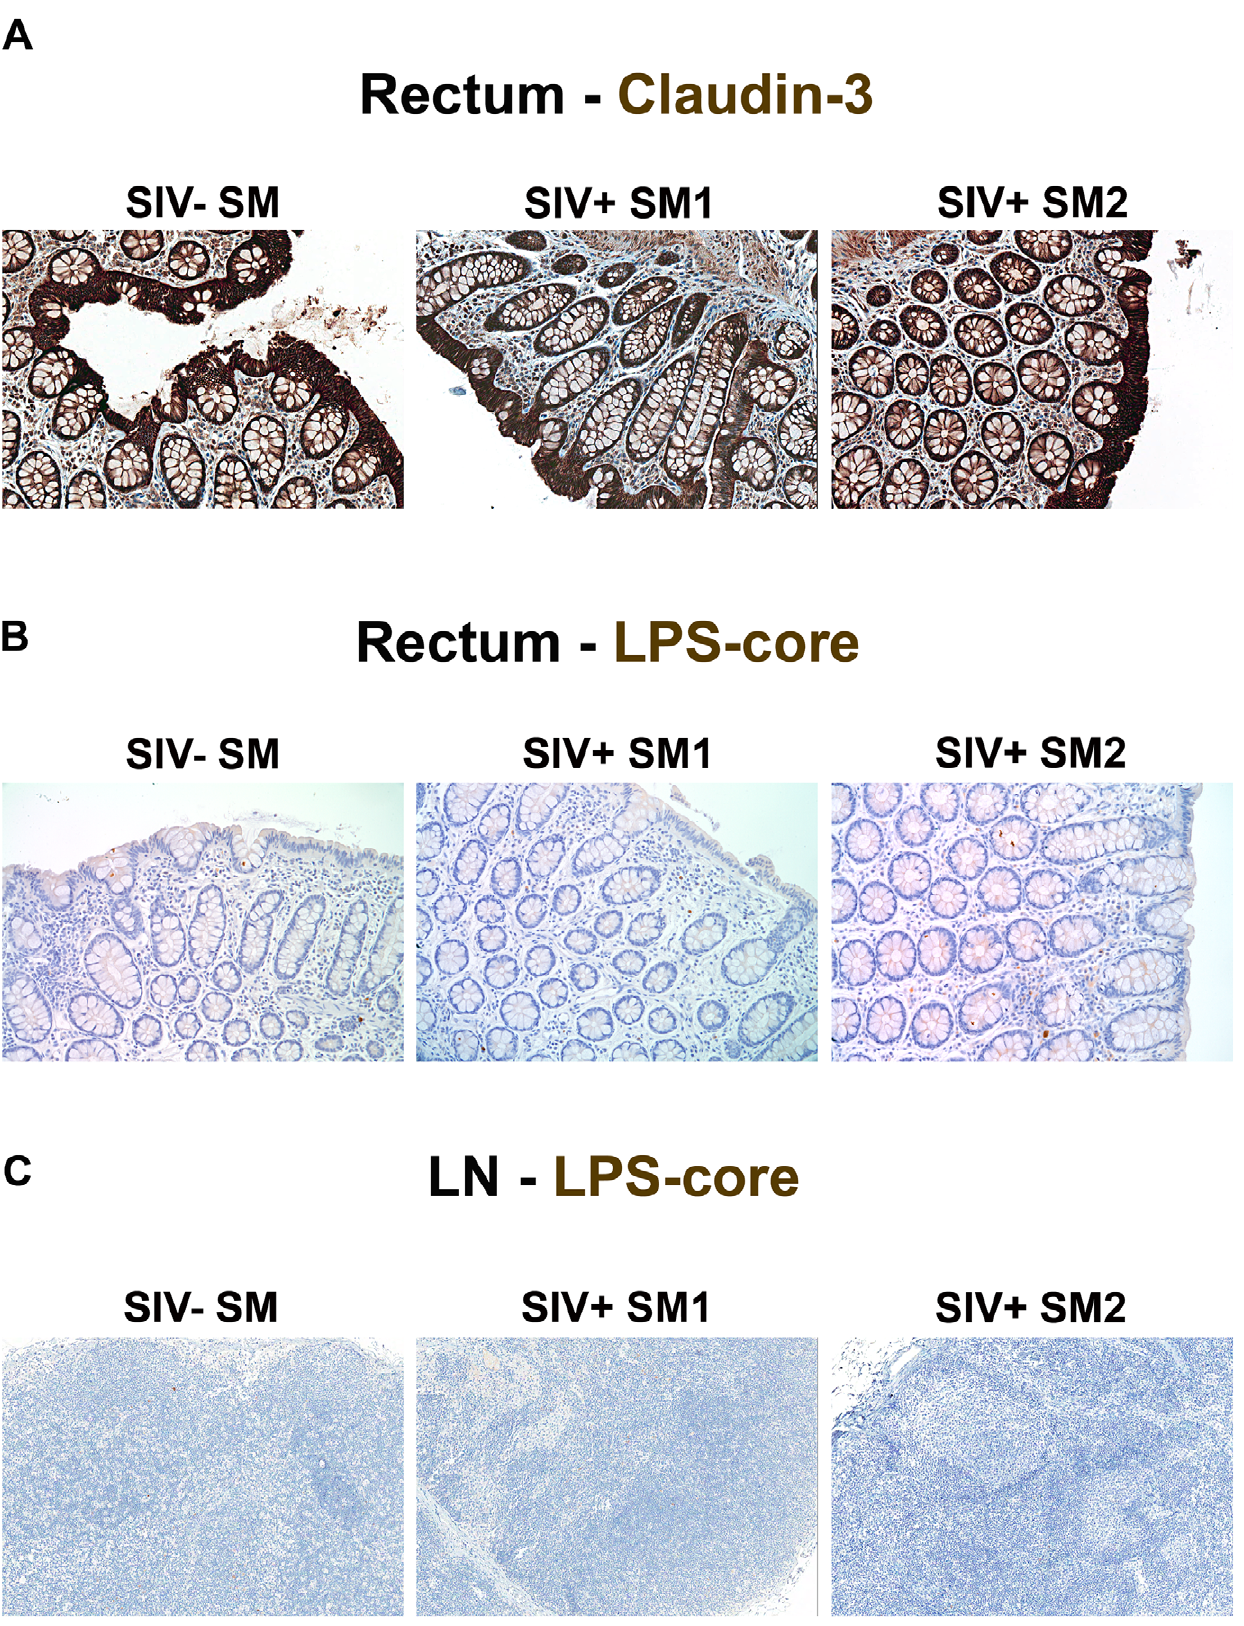
Figure 11. Absence of structural epithelial damage and microbial translocation in non-pathogenic infection of SMs. ( A ) Representative images (200 6 ) of rectum stained for the tight junction protein claudin-3 (brown) show the complete maintenance of the epithelial